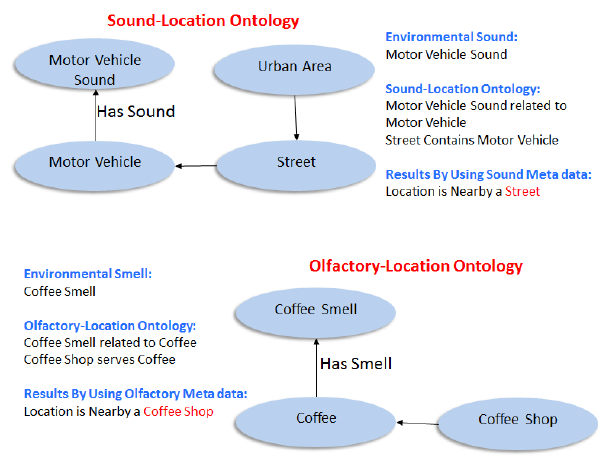
Figure 9 . Relations of sound and olfactory data with their corresponding locations The estimated position can used for dynamic training of the model. The taken images which do not exist in the geo- tagged dataset but are recognized through semantic map can be used for transfer learning to the model. Moreover, the positions which are not calculated properly can be assessed by system users to retrain the model by new